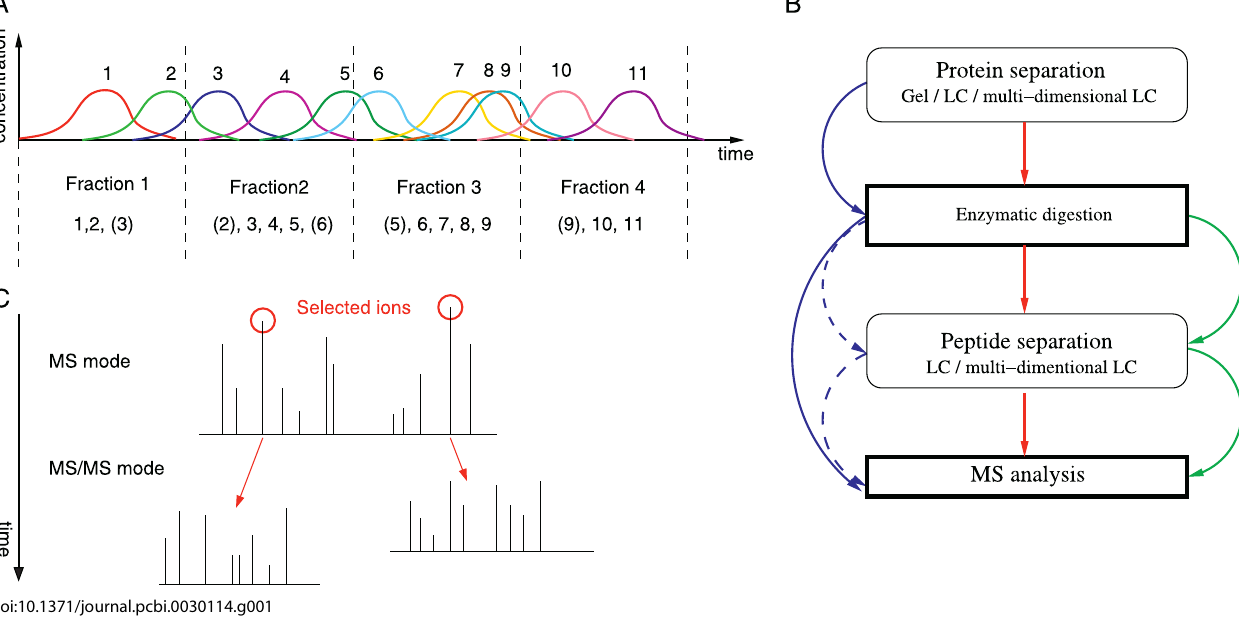
Figure 1. Steps in Sample Analysis by Proteomics (A) Sample complexity reduction via an LC column. This is applicable to both proteins and peptides. It is possible to collect fractions at fixed or variable time intervals to obtain a series of less complex samples; however, direct MS analysis is also an option. The figure illustrates how peptides/proteins 1–11 are fractionated. (B) Major steps in ‘‘ bottom-up ’’ proteomics and combinations thereof. Optional steps and essential steps are in rounded and bold rectangles, respectively. Green represents shotgun peptide sequencing entire sample digestion followed by multidimensional LC separation of peptides. Blue represents the classical gel approach, with or without (dashed arrows) peptide LC. Red combines protein and peptide LC. (C) Data-dependent MS/MS analysis. Here, ESI of a liquid sample and alternation of the instrument between MS and MS/MS modes is illustrated. The data generated is a sequence of peptide experimental m/z associated with the corresponding fragments m/z . The complete analysis is named an LC-MS run.